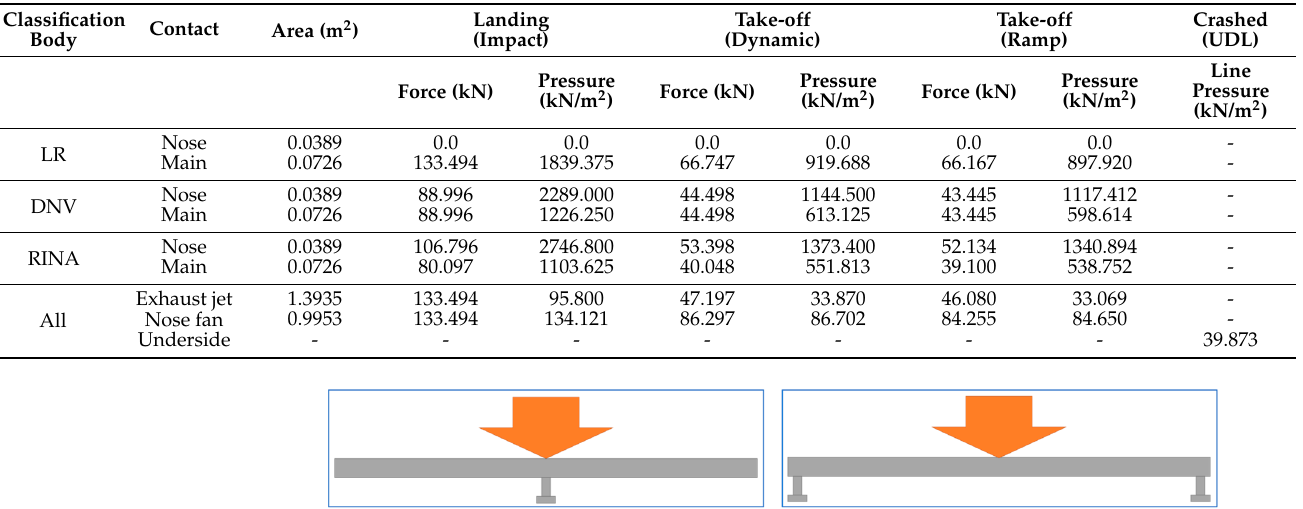
Table 2. Details of the forces and pressures for each wheel or jet/fan based on weight distribution according to each classification body.